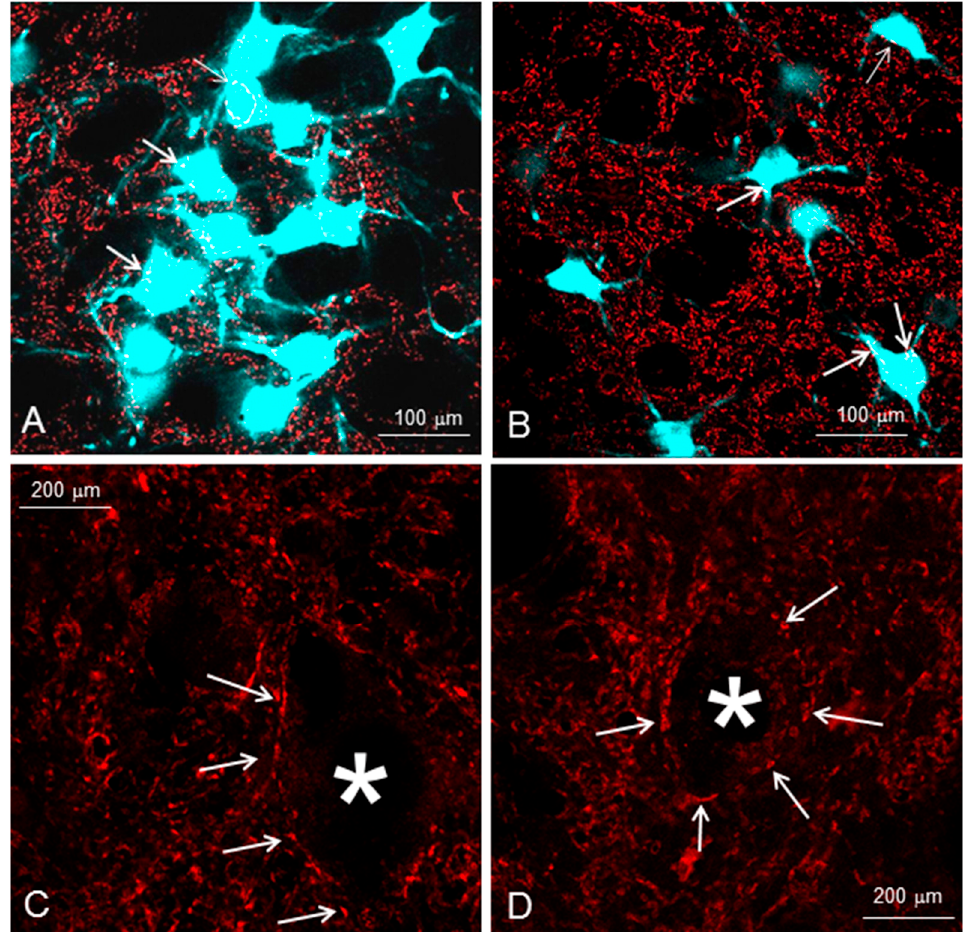
Figure 6. Analysis of perisomatic puncta. Low-power confocal images (1-µm-thick optical slices) show the appearance of synaptophysin-positive puncta (arrows) around intact ( A ) and axotomized ( B ) facial motoneurons, identified by the retrograde labeling with FB. High-power confocal images used for counting: ( C ) intact and ( D ) axotomized motoneuronal cell bodies (*), four months after regeneration following facial and infraorbital nerve transection and end-to-end suture. Immunostained sections through the facial nucleus were examined under a fluorescence microscope. Stacks of images of 1 µm thickness were obtained on a TCS SP5 confocal microscope (Leica) using a 40 × oil immersion objective and digital resolution of 1024 × 1024 pixels. Four adjacent stacks (frame size, 115 × 115 µm) were obtained consecutively in a rostrocaudal direction to sample more motoneurons. One image per cell at the level of the largest cell body cross-sectional area was used to count the number of perisomatic puncta. Motoneurons were easily identified by the retrograde labeling with fast blue (FB). Areas and perimeters were measured using the Image Tool 2.0 software program (University of Texas, San Antonio, TX, USA). Linear density was calculated as the number of perisomatic puncta per unit length. Between 105 and 120 cells were analyzed per group and parameter. From Bendella et al. (2011)